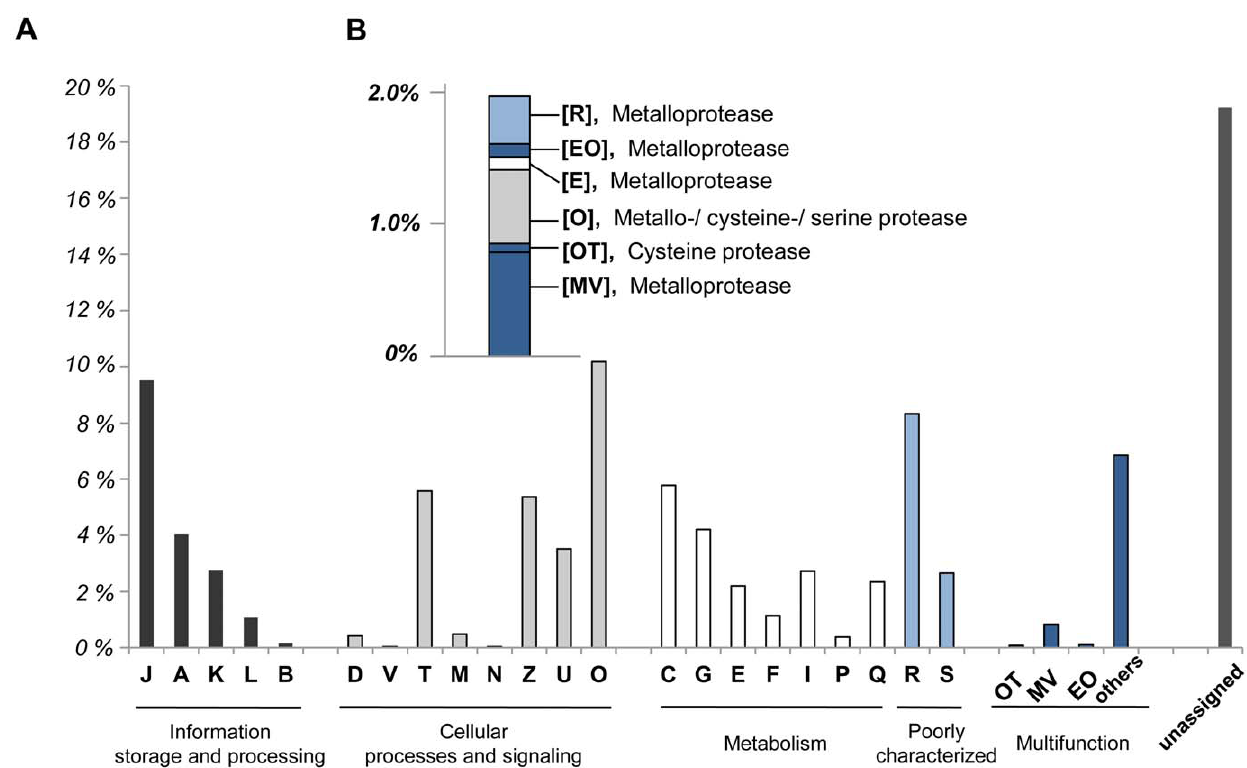
Figure 3. KOG category distribution of the putative functional genes of kinetoplastid origin. (A) The relative percent of reads in terms of their assigned KOG categories are shown. The KOG category grouping is as follows: J, translation, ribosomal structure and biogenesis; A, RNA processing and modification; K, transcription; L, replication, recombination and repair; B, chromatin structure and dynamics; D, cell cycle control, cell division, chromosome portioning; V, defense mechanisms; T, signal transduction mechanisms; M, cell wall/membrane/envelope biogenesis; N, cell motility; Z, cytoskeleton; U, intracellular trafficking, secretion, and vesicular transport; O, posttranslational modification, protein turnover, chaperones; C, energy production and conversion; G, carbohydrate transport and metabolism; E, amino acid transport and metabolism; F, nucleotide transport and metabolism; I, lipid transport and metabolism; P, inorganic ion transport and metabolism; Q, secondary metabolites biosynthesis, transport and catabolism; R, general function prediction only; and S, function unknown. Those not assigned by the Kognitor analysis are denoted as ‘‘unassigned.’’ (B). Putative protease-encoding genes of the category groupings suggested by our microscopic observations.